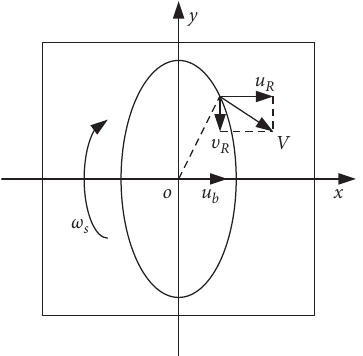
Figure 2: Ball speed vector in spinning